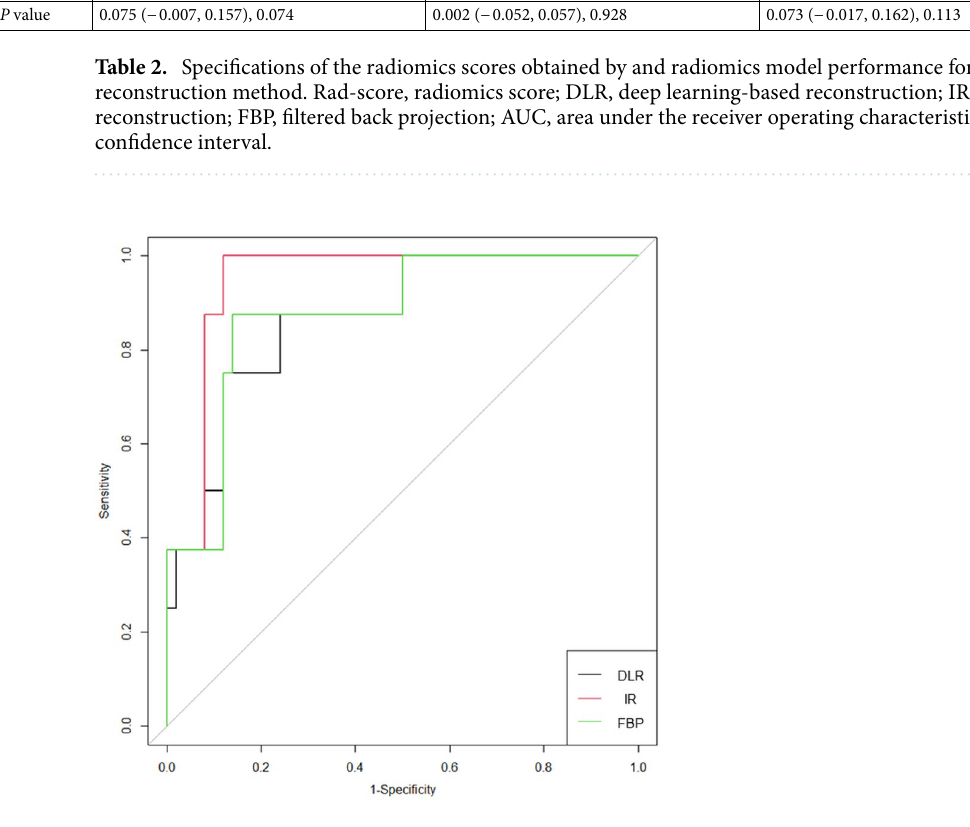
Figure 3. Receiver operating characteristic curves of radiomics models from three different reconstruction methods. DLR, learning-based reconstruction; IR, iterative reconstruction; FBP, filtered back